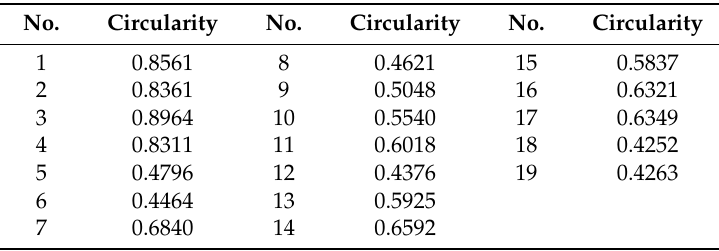
Table 1. Results of circularity determination.